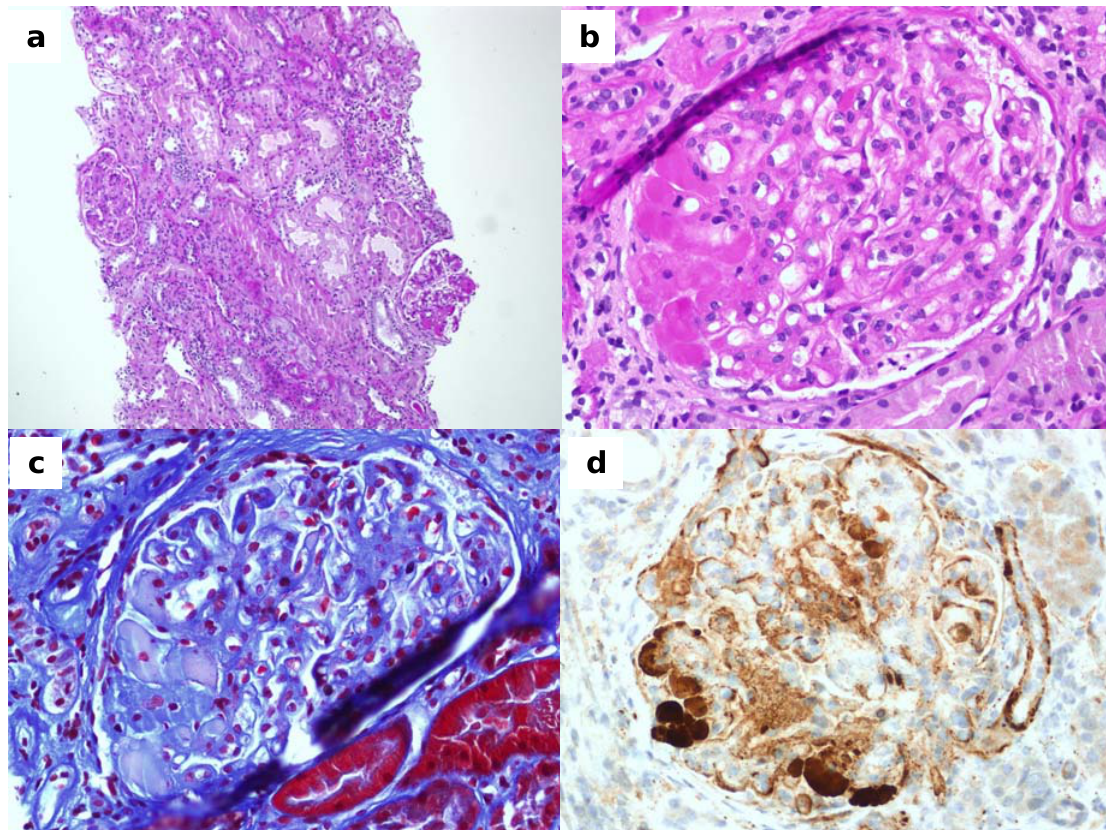
Figure 2. A patient with nephrotic syndrome, type 2 diabetes and hepatitis C virus associated crioglobulinemia. ( a ) Hematoxilyn-eosin at 100× magnification showing a glomerulus with mesangial expansion and another with glomerular thombi; ( b ) periodic acid Schiff (PAS) stain at 400× magnification of the glomerulus showing thrombi; ( c ) same glomerular section at 400× magnification stained with Masson’s trichrome ( d ) immunohistochemistry showing subendothelial C3 deposition in the glomerular